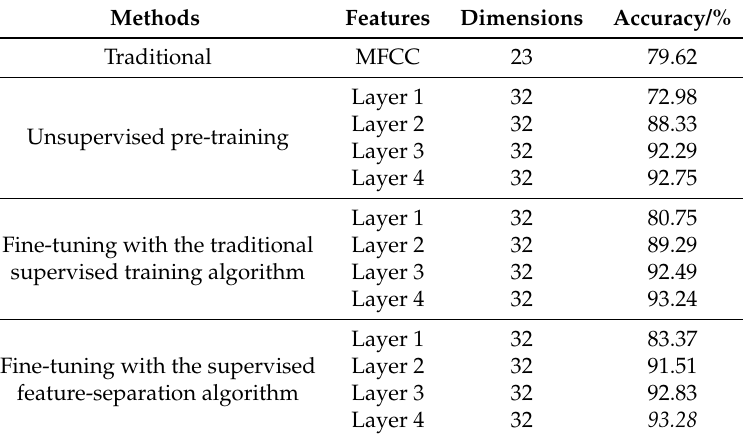
Table 3. Average Recognition